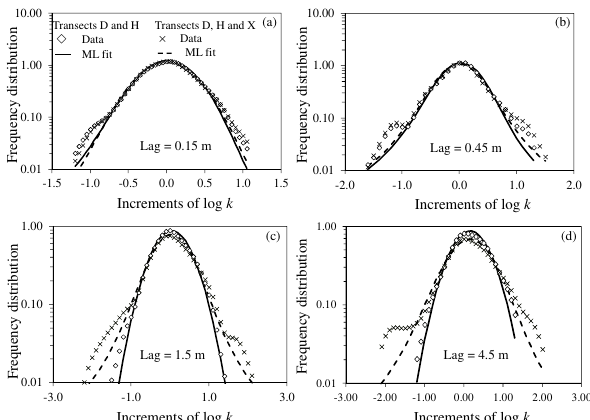
by Castle et al. (2004) has shown them to be Gaussian only at a 51 % confidence